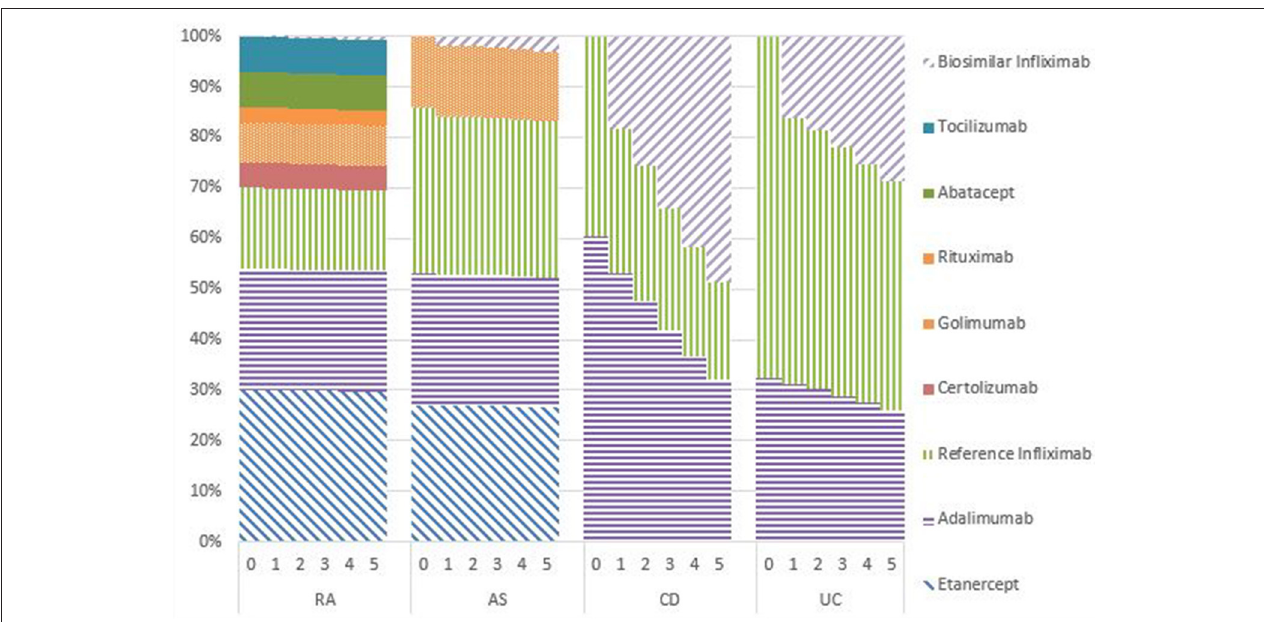
FIGURE 5 | Market shares biologics Italy in years